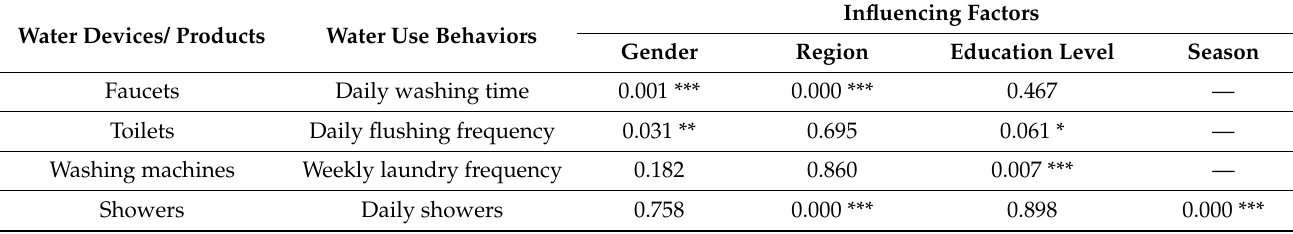
Table 2. Analysis results of difference between water use behavior and influencing factors ( p